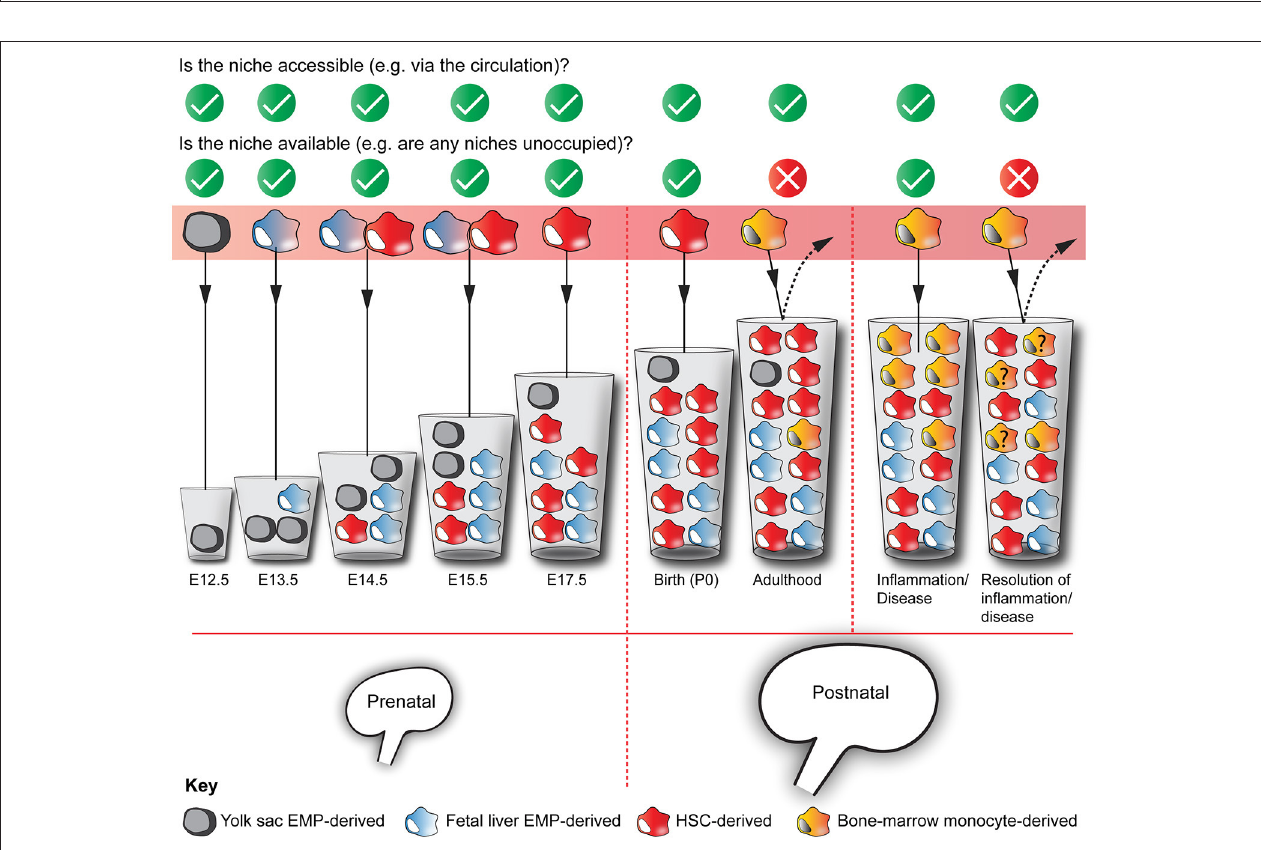
FIGURE 3 | Multiple origins of kidney macrophages. Murine kidneys contain macrophages that are derived from multiple sources, with their relative proportions fluctuating throughout development and adulthood. Based on the niche competition hypothesis of macrophage origins (Guilliams and Scott, 2017), we argue that the mixed ontogeny of kidney macrophages is the result of kidney niches being both accessible and available to macrophage precursors throughout kidney development and phases of adulthood. The “ ? ” in some of the yellow bone marrow-derived monocytes denotes that we do not know whether these cells are maintained in the kidney after the resolution of inflammation/disease. The increasing volumes of the cups represent the increasing capacity of the kidney to house macrophages.